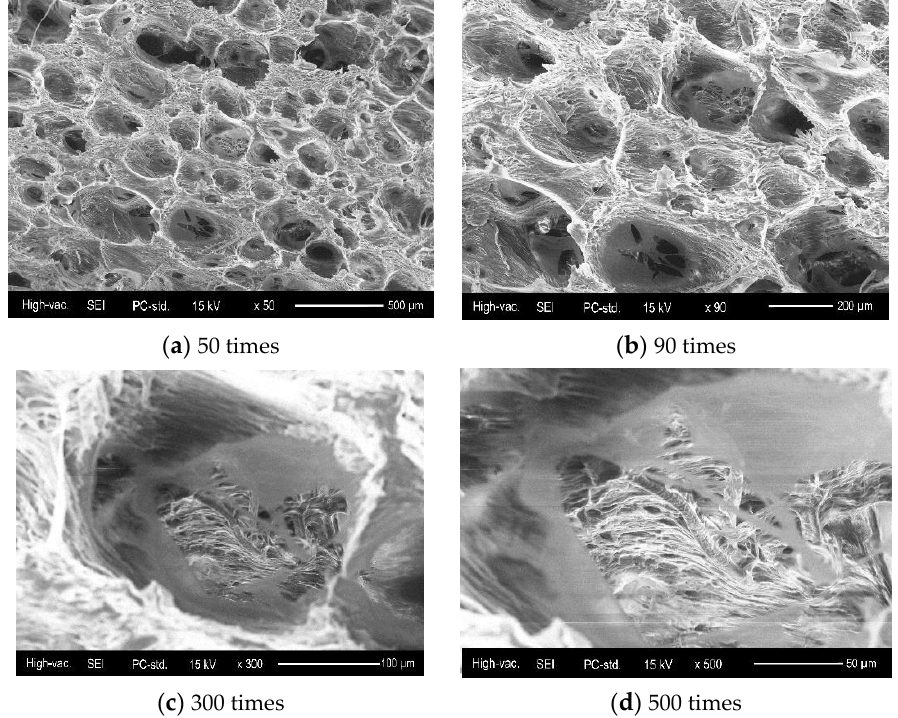
Figure 3. Morphology of an internal section of a sample (PVA content of 10.91%) with different magnifications. ( a ) 50 times;